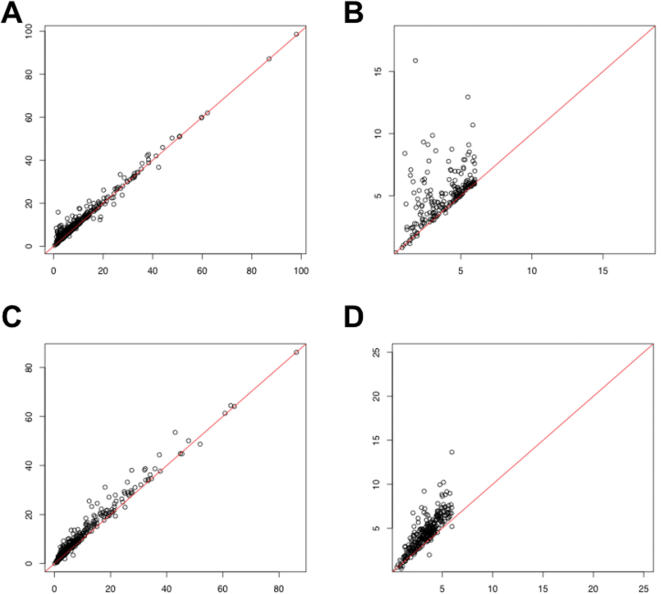
Effects of probe selection on genes differentially expressed between liver and muscle.(A) 438 transcript clusters were defined as overexpressed in liver relative to muscle, based on 3′ expression array data (see Materials and Methods).Using gene expression indexes computed from all core probes or the selected core probes, we calculated the average gene expression fold change in three liver samples over three muscle samples.The X-axis shows the fold change using all core probes, and the Y-axis shows the fold change using selected core probes.The red line indicates the 45-degree line (Y = X).(B) A magnification of (A) when the fold change computed from all core probes was less than 6.(C) 500 transcript clusters were defined as overexpressed in muscle relative to liver, based on 3′ expression array data (see Materials and Methods).Using gene expression indexes computed from all core probes or the selected core probes, we calculated the average gene expression fold change in three muscle samples over three liver samples.The X-axis shows the fold change using all core probes, and the Y-axis shows the fold change using selected core probes.The red line indicates the 45-degree line (Y = X).(D) A magnification of (C) when the fold change computed from all core probes was less than 6.